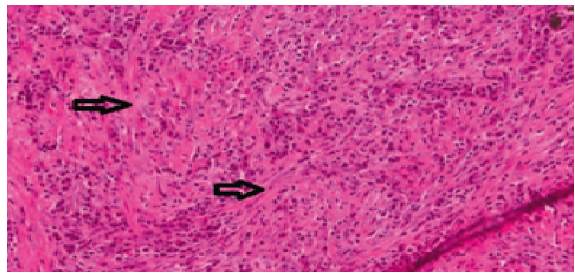
Figure 5: High power field showing fibrous bands.